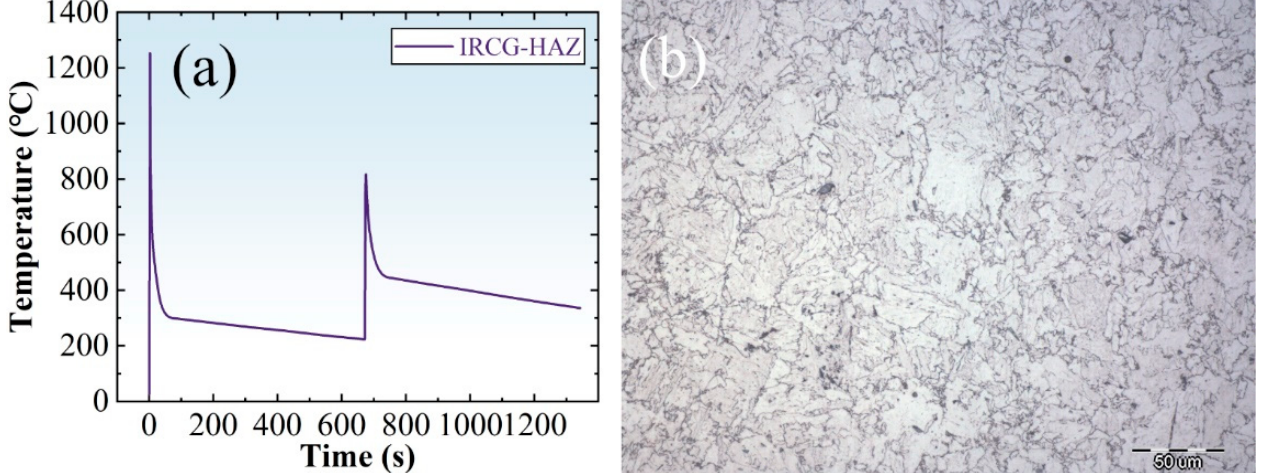
Figure 12. Thermal processes of IRCG-HAZ and the thermal simulation microstructures (with a magnification of 500): ( a ) thermal cycles calculated for thermal simulation of IRCG-HAZ; ( b ) microstructures of thermal simulated IRCG-HAZ.